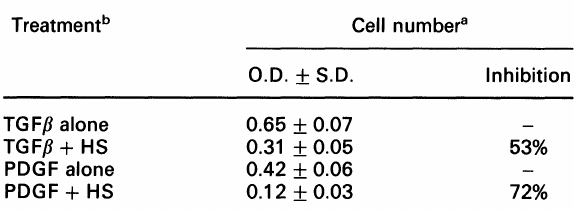
Table 2. Effect of HS on TGF/ and PDGF induced Nor-10 proliferation Treatment b